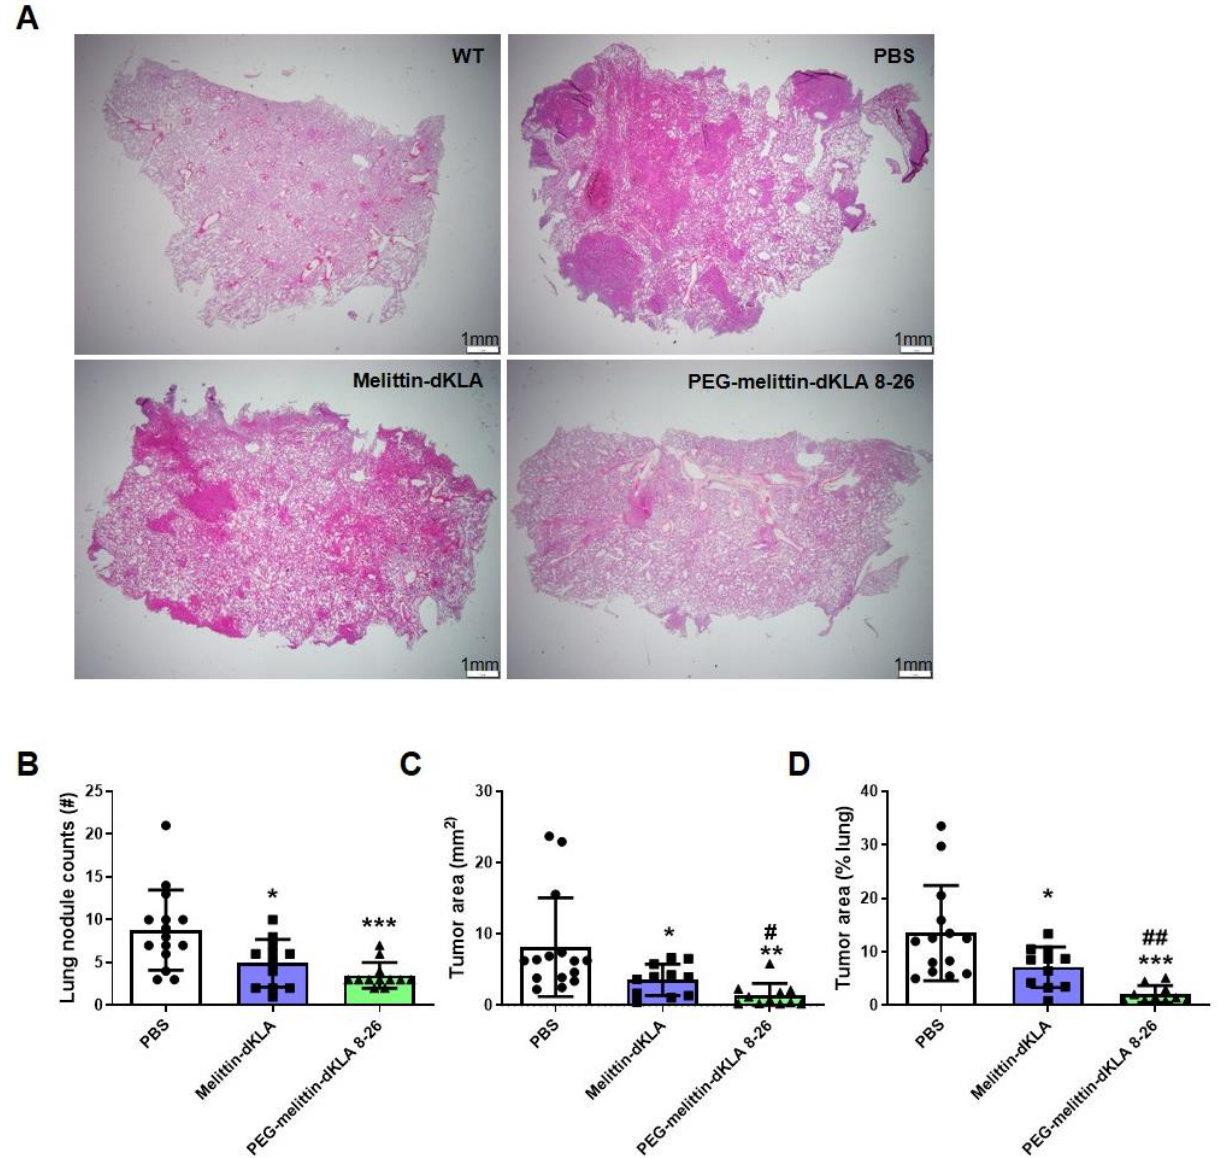
Figure 6. Enhanced suppression of lung metastasis by PEG-melittin-dKLA 8-26 in the TNBC mouse model. ( A ) Image of H&E-stained lung tissue. Magnification, 1.25×. Scale bar, 1mm. ( B ) Lung nodule counts and ( C , D ) lung nodule area were calculated using Image J. All data are presented as the mean ± SEM; * p < 0.05, ** p < 0.01, *** p < 0.001 versus the PBS group, # p < 0.05, ## p < 0.01 versus the Melittin-dKLA group (n = 12).